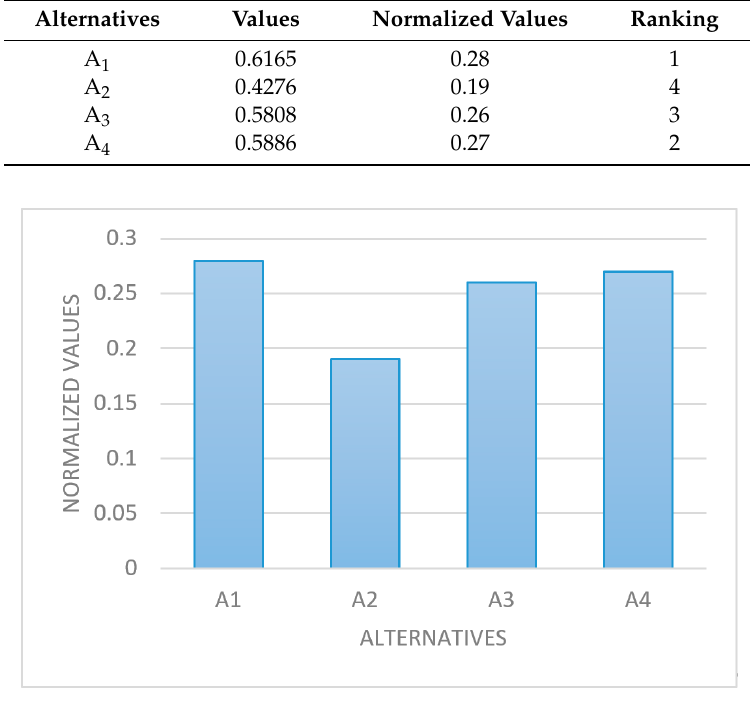
Figure 9. Final ranking using the AHP method.